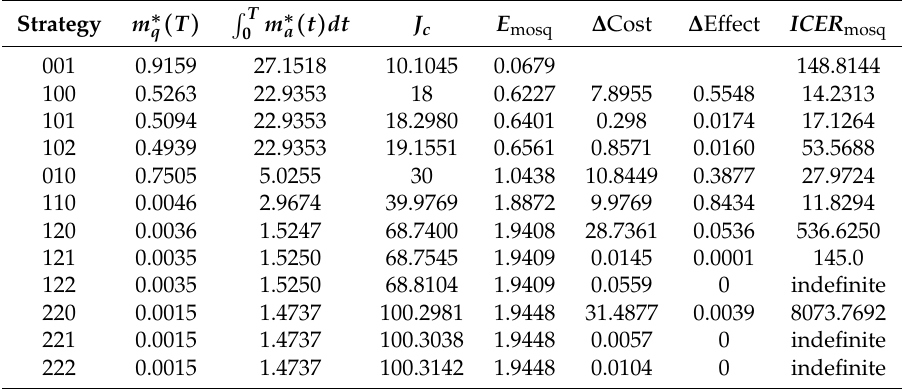
Table 5. Incremental Cost-Effectiveness Ratio (ICER) calculation for strategies fulfilling the ascendant order for the costs J c and corresponding effects E mosq on suppression of the mosquito population.